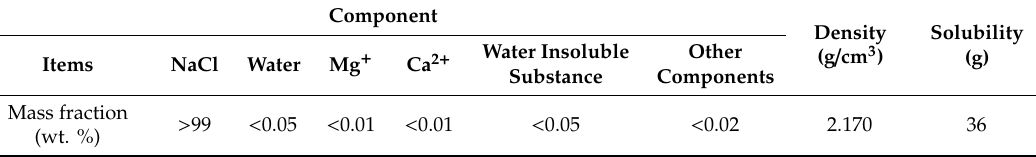
Table 3. Technical Indicators of Chloride Salt.